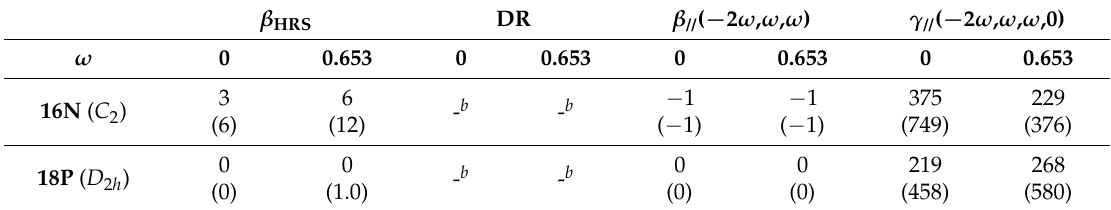
Table 10. β HRS and depolarization ratio (DR), longitudinal component of first and second hyperpolarizability ( β // and γ // of meso -substituted porphyrinoids in the static and dynamic regime a .